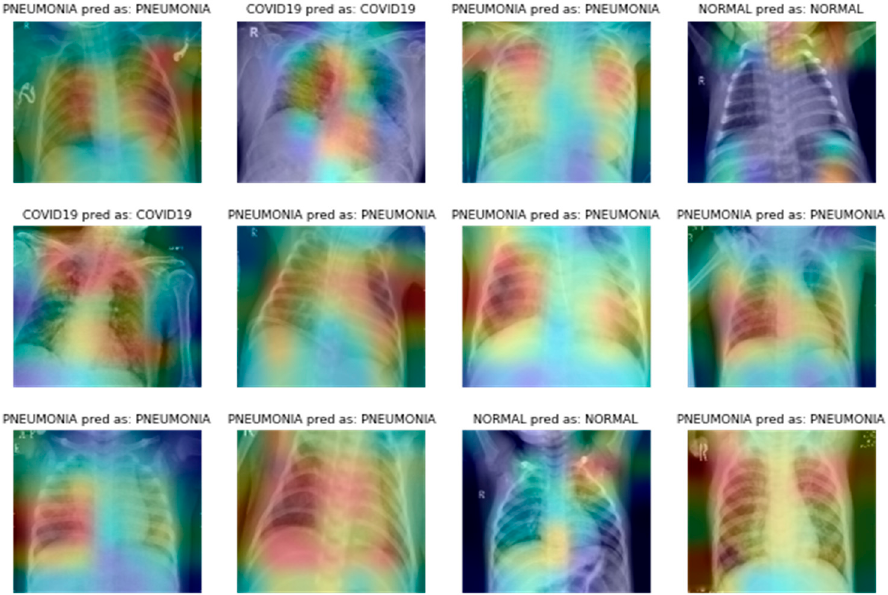
Figure 12. The segmented CXR image heat maps show the proposed models’ decision-making capabilities for different chest diseases. Table 6. Performance comparison of proposed work with earlier